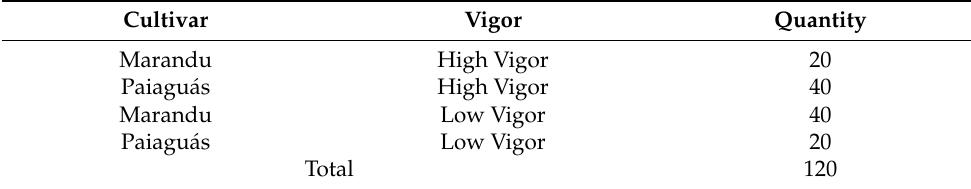
Table 1. Detail of the sample set used.